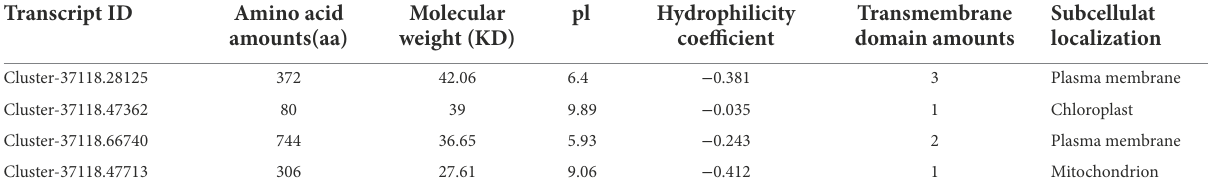
TABLE 4 Physical and chemical properties and subcellular localization prediction of hub gene protein related to cold tolerance in H.